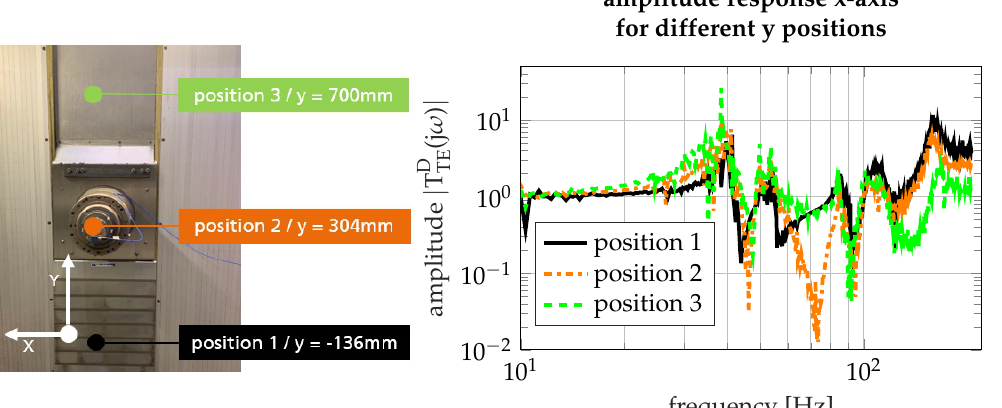
Figure 6. Position depending behaviour of T D